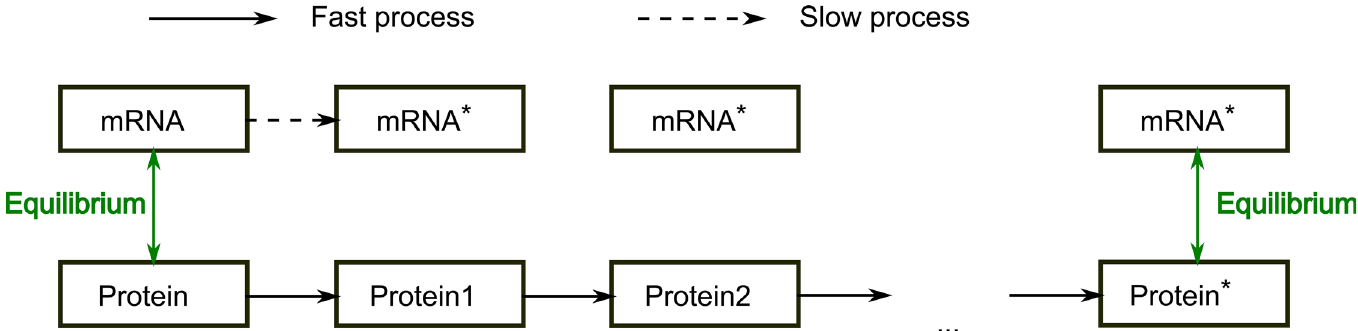
Fig 3. Graphical representation of the updating scheme. Every node consists of two variables, denoting the slow and fast processes, here dubbed mRNA and protein respectively. Every time the slow variables are updated, the fast variables are randomly selected to update until equilibrium is reached. Then, another slow variable is randomly updated repeating the process until overall equilibrium is